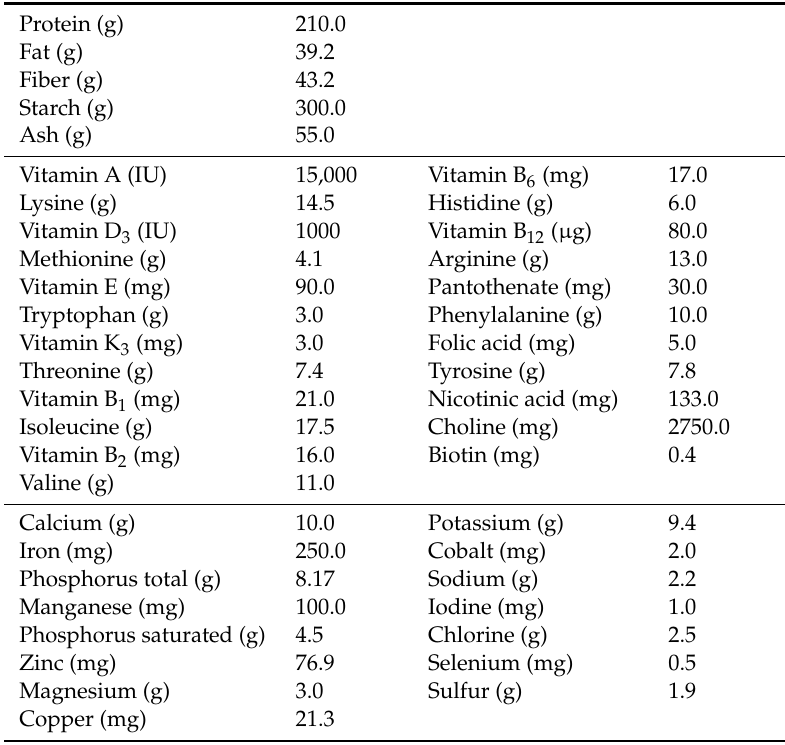
Table 1. Declared dietary composition of Labofeed H (per kg of